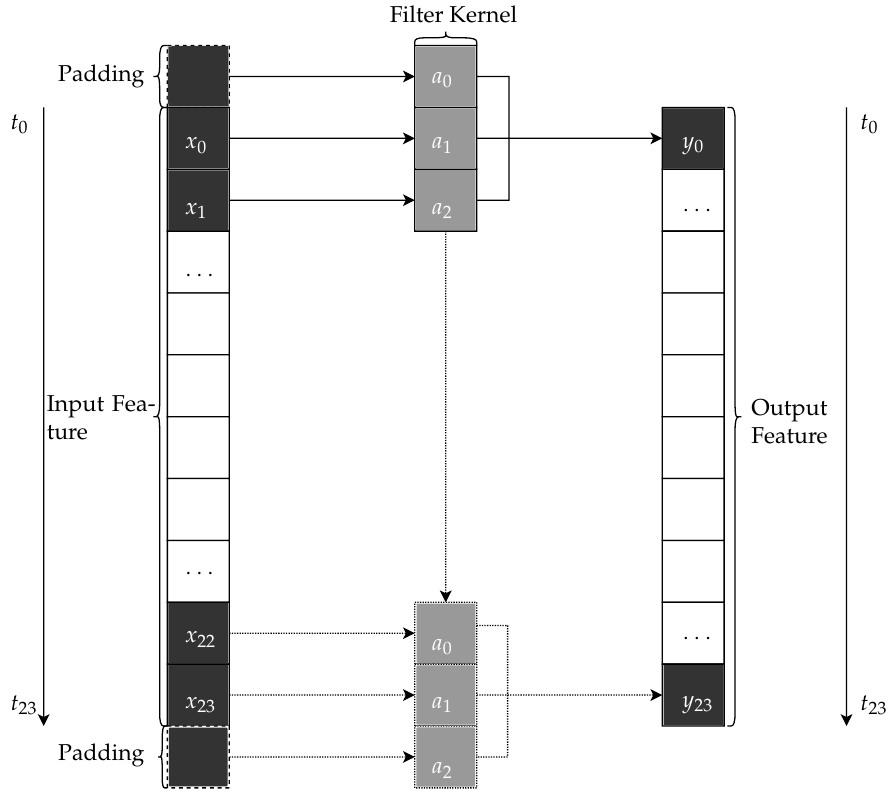
Figure 2. Example one-dimensional CNN with a filter of size 1 × 3. We keep the time series’ dimension and extract relevant information by applying the filter to an input time series size of 1 × 24 with additional